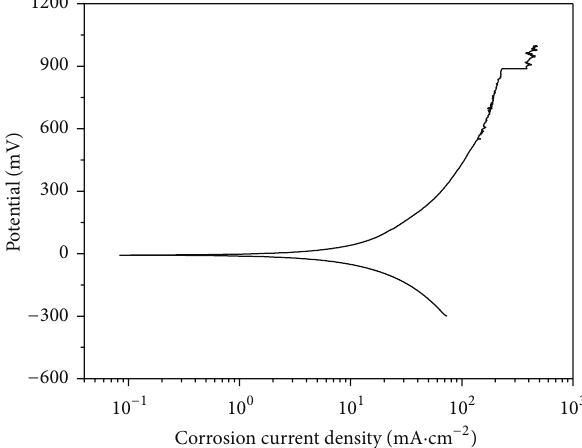
Figure 4: Polarization curve for AISI-309 exposed to 50mol% V 2 O 5 -50 mol% Na 2 SO 4 at 700 ∘